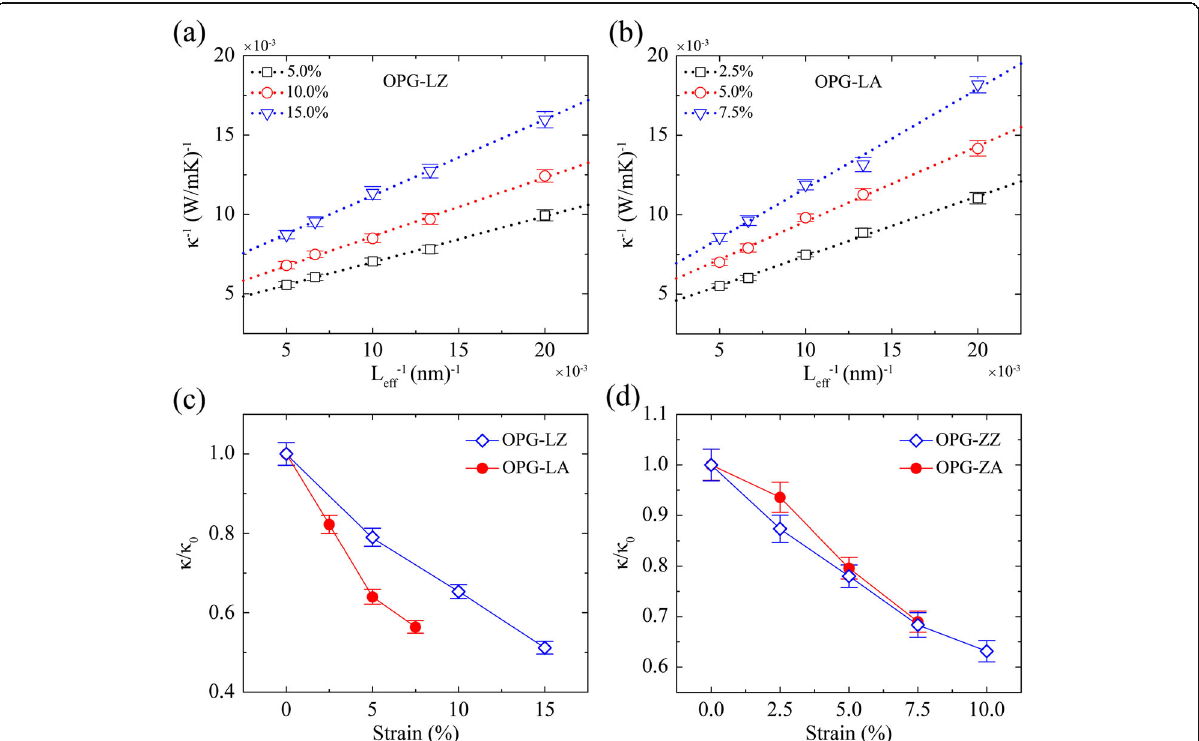
Fig. 10 Inverse TC of a OPG-LZ, b OPG-LA at various uniaxial strains as a function of the inverse sample length, and the relative TC ( κ / κ 0 ) of c OPG-L and d OPG-Z as a function of strain. κ 0 is the TC of stress free at 300 K, which is 310 W/mK, 332 W/mK, 247 W/mK, and 227 W/mK for κ OPG-